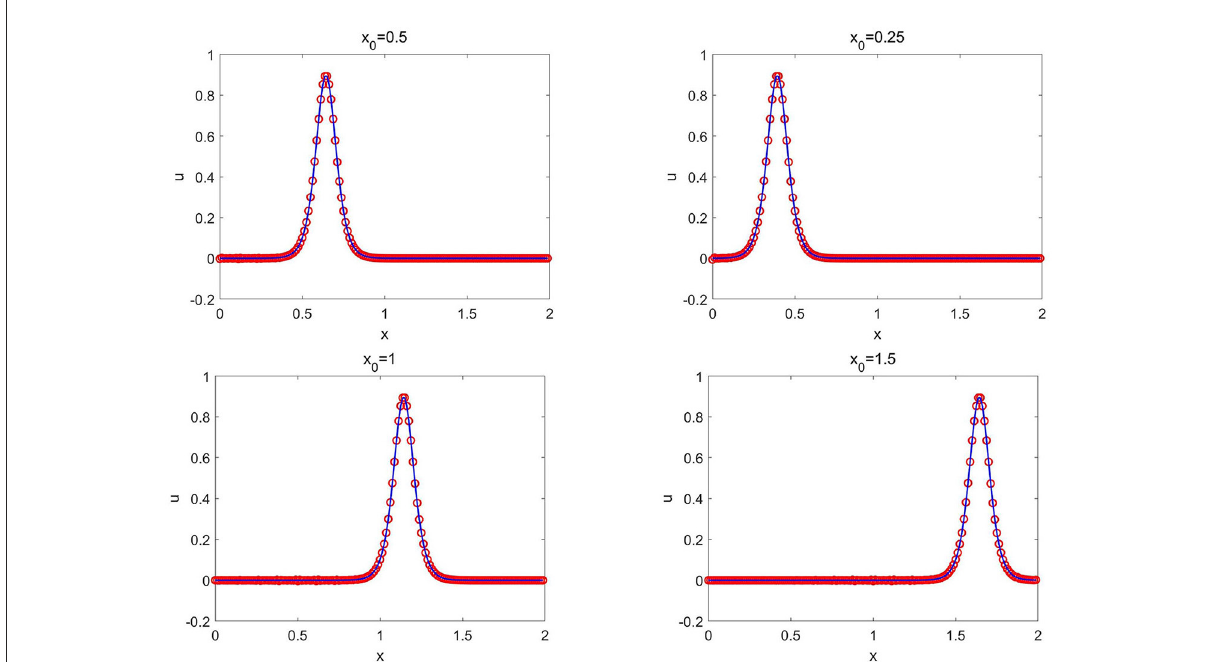
FIGURE3 Soliton solutions (3.2) of Example 3.1: the CANN solution (red circles) and the exact solution (solid blue lines) at T values of x 0 .